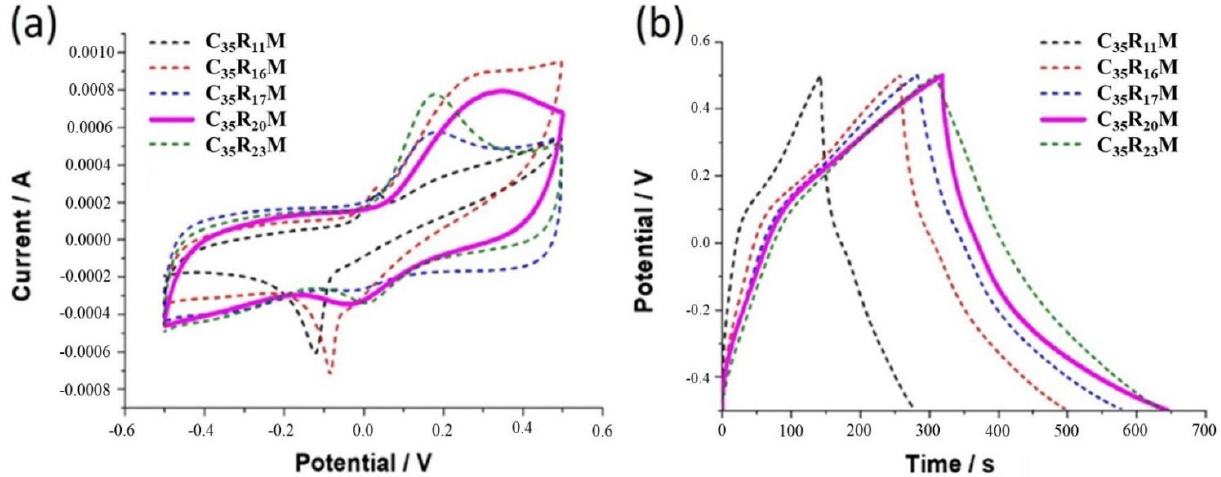
Figure 3. ( a ) CV curves of C 35 R y M electrodes with various Ru contents, at a scan rate of 10 mV s −1 , and ( b ) GCD curves of C 35 R y M electrodes with various Ru contents, at a current density of 1 A·g −1 . Table 1. The specific capacitances R s and R ct of the C x R y M electrodes evaluated by CV curves, GCD curves and Nyquist plots with various contents of Ru.